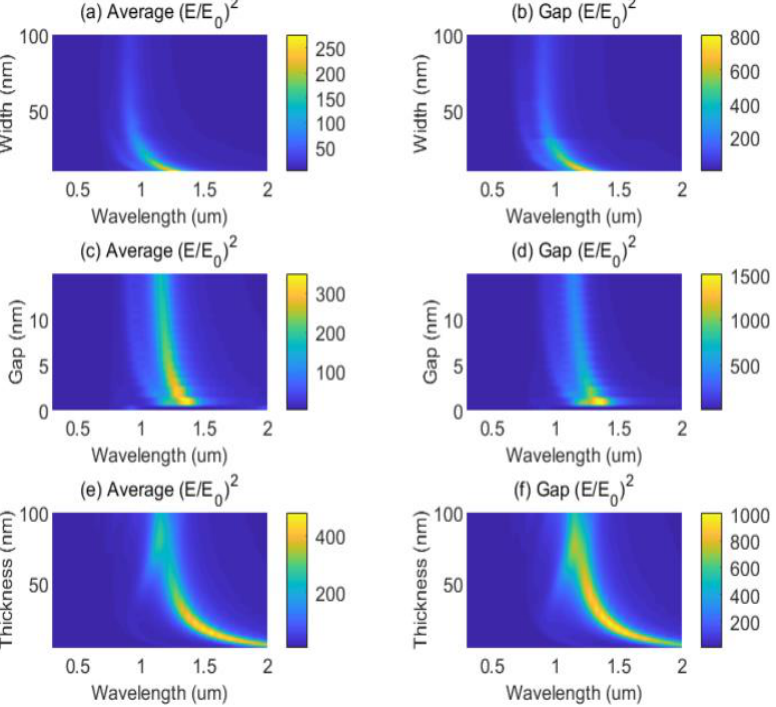
Figure 4. The average enhancement factor over the simulation object and the average enhancement factor over the gap of the PGNB on a flat sapphire substrate depend on various geometrical parameters and incident wavelength. The incident light source, with a wavelength range between 0.3 µ m and 2 µ m and a polarization angle of 90 degrees (the polarization direction was oriented at the y -axis), was illuminated on the PGNB vertically. ( a , b ): the average enhancement factor over the simulation object and the average enhancement factor over the gap of the PGNB depend on width and incident wavelength, respectively; ( c , d ): the average enhancement factor over the simulation object and the average enhancement factor over the gap of the PGNB depend on the gap size and incident wavelength; ( e , f ): the average enhancement factor over the simulation object and the average enhancement factor over the gap of the PGNB depend on the thickness and incident